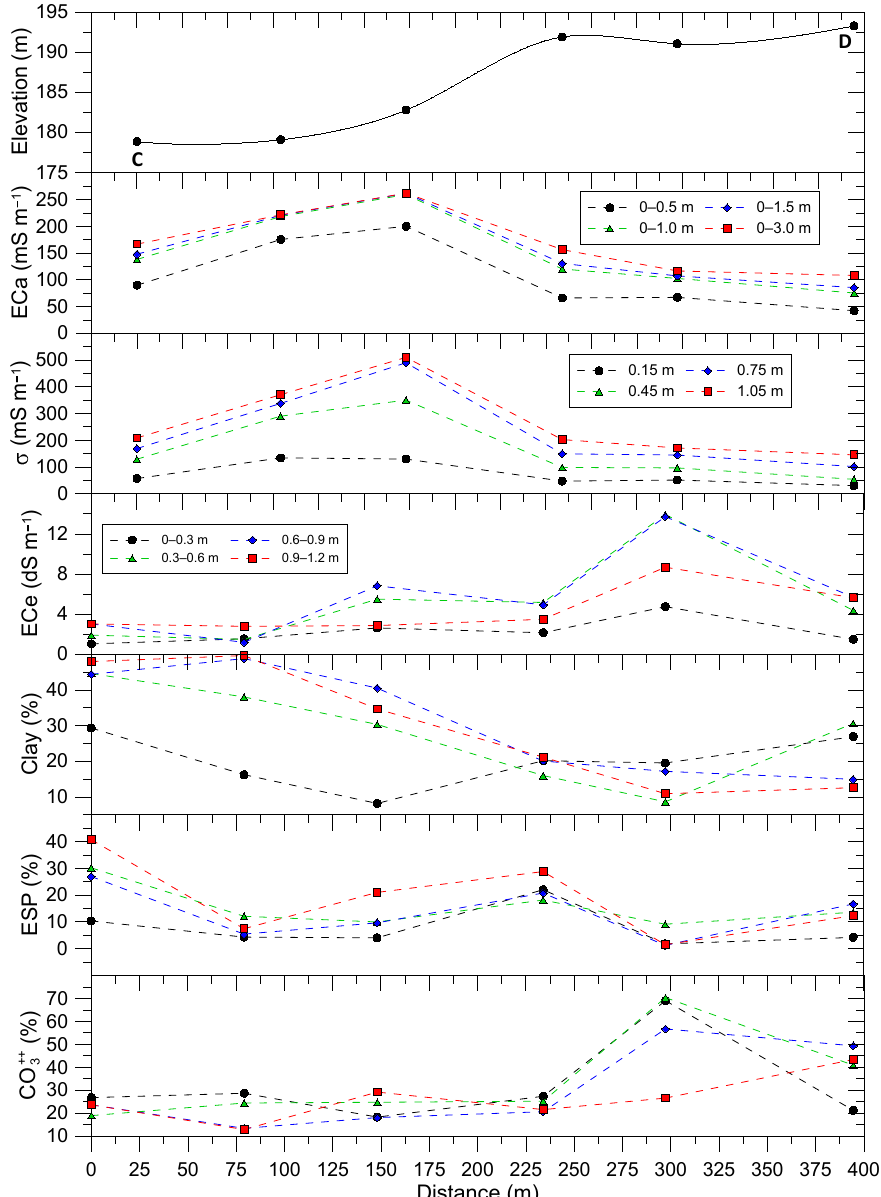
Figure 11. Elevation and different soil properties measured in 2017 along the transect T2 C–D (Figure 1).